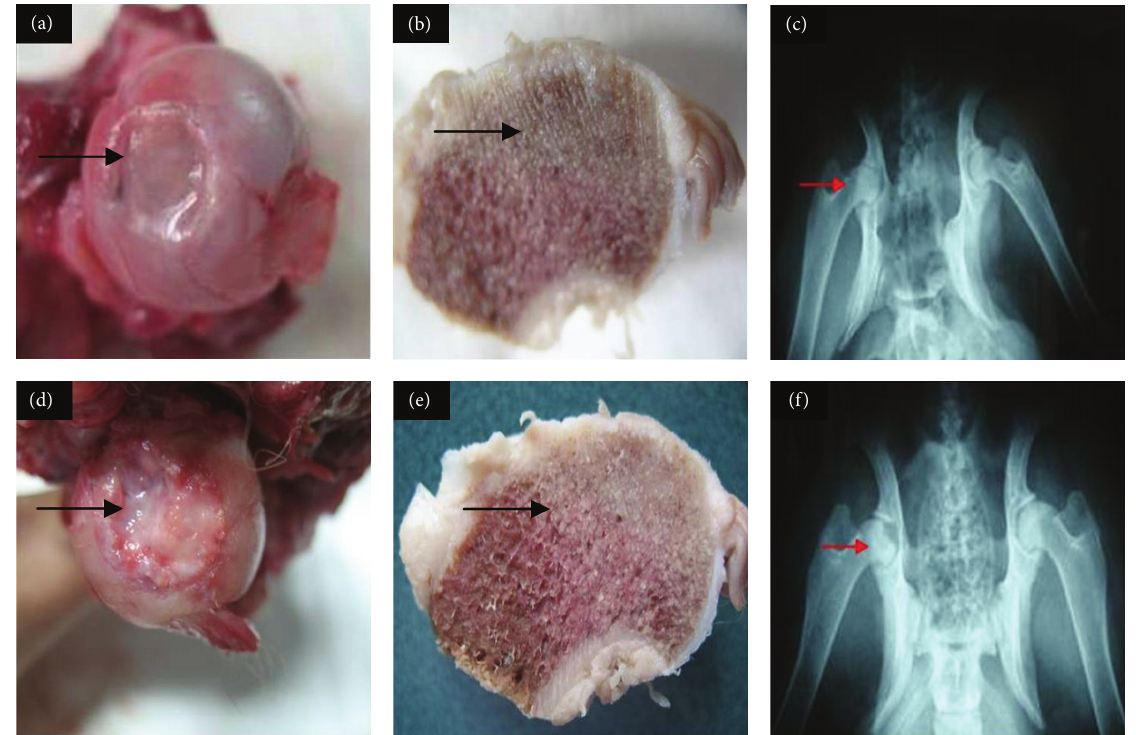
Figure 6: Radiography and gross morphology of canine femoral heads: gross morphology of cartilage at (a) 3 months after repair and (b) bone at 3 months; (c) radiography of the femoral head at 3 months; gross morphology of cartilage at (d) 6 months after repair and (e) bone at 6 months; (f) radiography of the femoral head at 6 months.